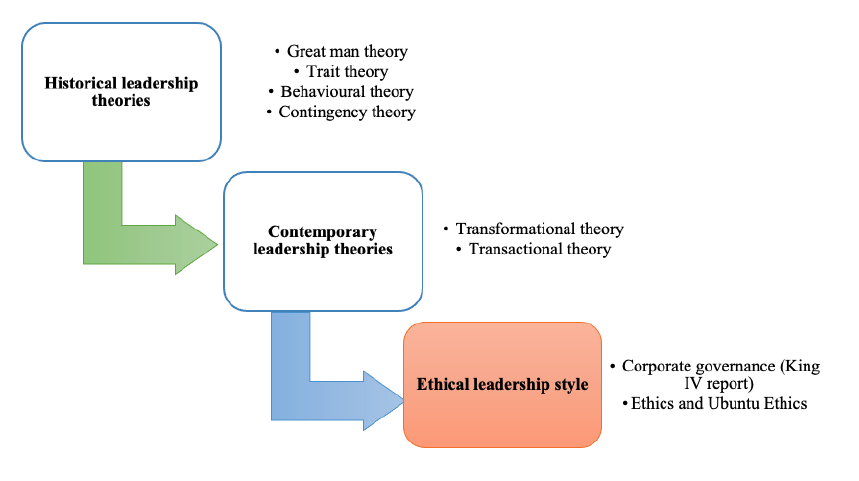
Figure 2: Relationship between Leadership Theories and An Ethical Leadership Style; Source: